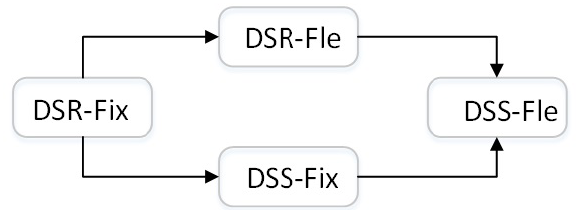
Figure 1. The algorithm framework for DSS-Fle. Derived from DSR-Fix, we first propose DSR-Fle and DSS-Fix algorithms, and derived from DSR-Fle and DSS-Fix together, we propose the DSS-Fle